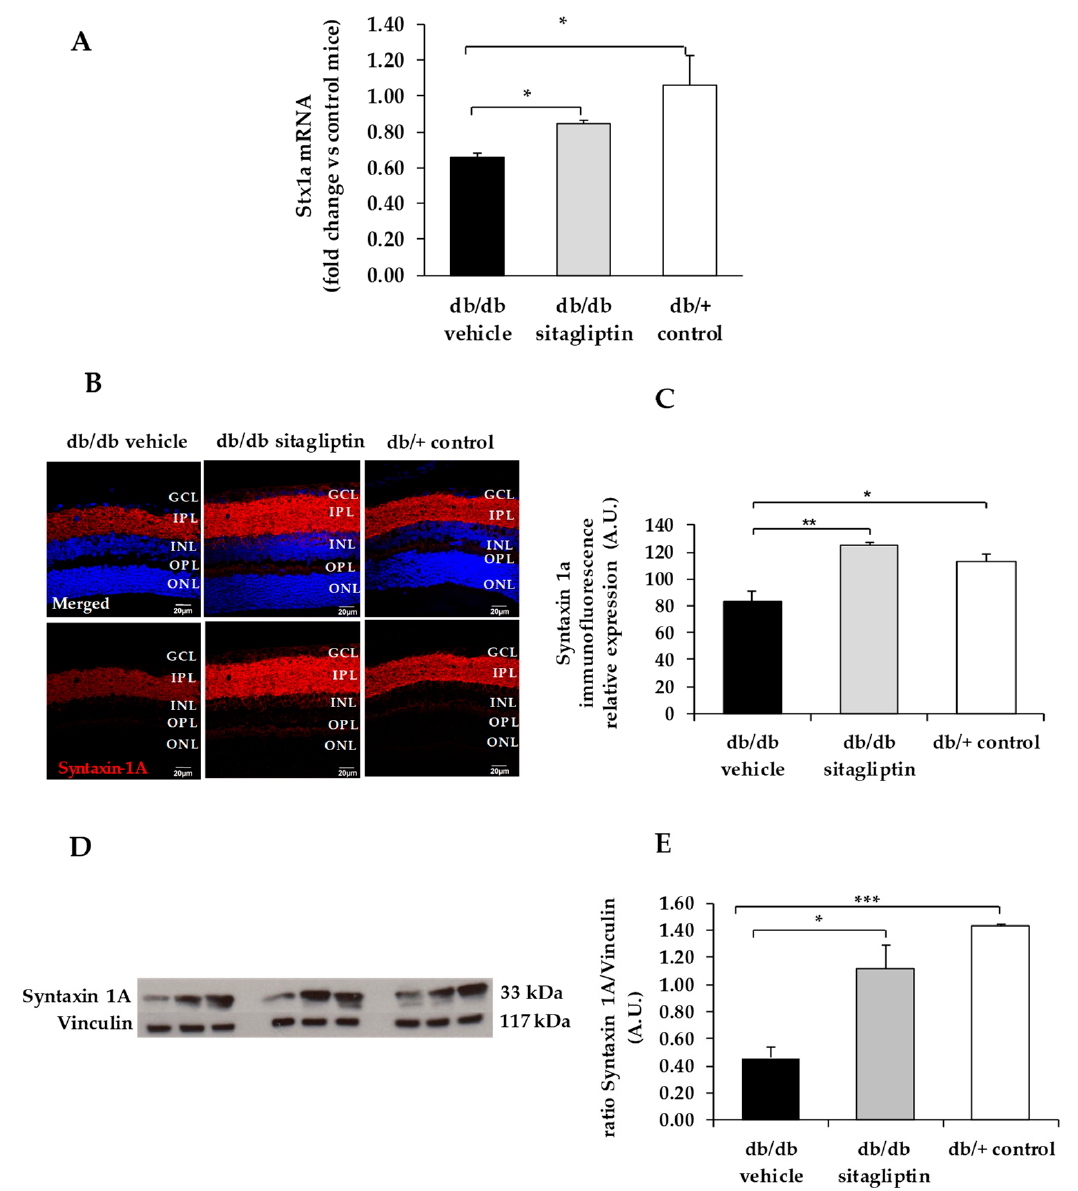
Figure 4. ( A ) Real-time quantitative RT-PCR analysis of syntaxin 1A gene (Stx1a) in db/db mice treated with vehicle (black bars), sitagliptin eye drops (grey bars), and in non-diabetic mice (white bars). ( B ) Immunofluorescence of syntaxin 1A (red) among representative samples of diabetic retinas of experimental groups. Hoechst staining (blue) was used for nuclei labeling. ONL: outer nuclear layer; OPL: outer plexifom layer; INL: inner nuclear layer; IPL: inner plexiform layer; GCL: ganglion cell layer. Scale bars, 20 µ m. ( C ) Quantification of syntaxin 1A mmunofluorescence in diabetic mice treated with vehicle eye drops (black bars), sitagliptin eye drops (grey bars), and in non-diabetic retinas (white bars). ( D ) Western blot bands of syntaxin 1A and ( E ) Densitometric analysis in db/db mice treated with vehicle eye drops (black bars), sitagliptin eye drops (grey bars), and in non-diabetic mice retinas (white bars). Protein levels were normalized with vinculin. * p < 0.05, ** p < 0.01, *** p < 0.001.